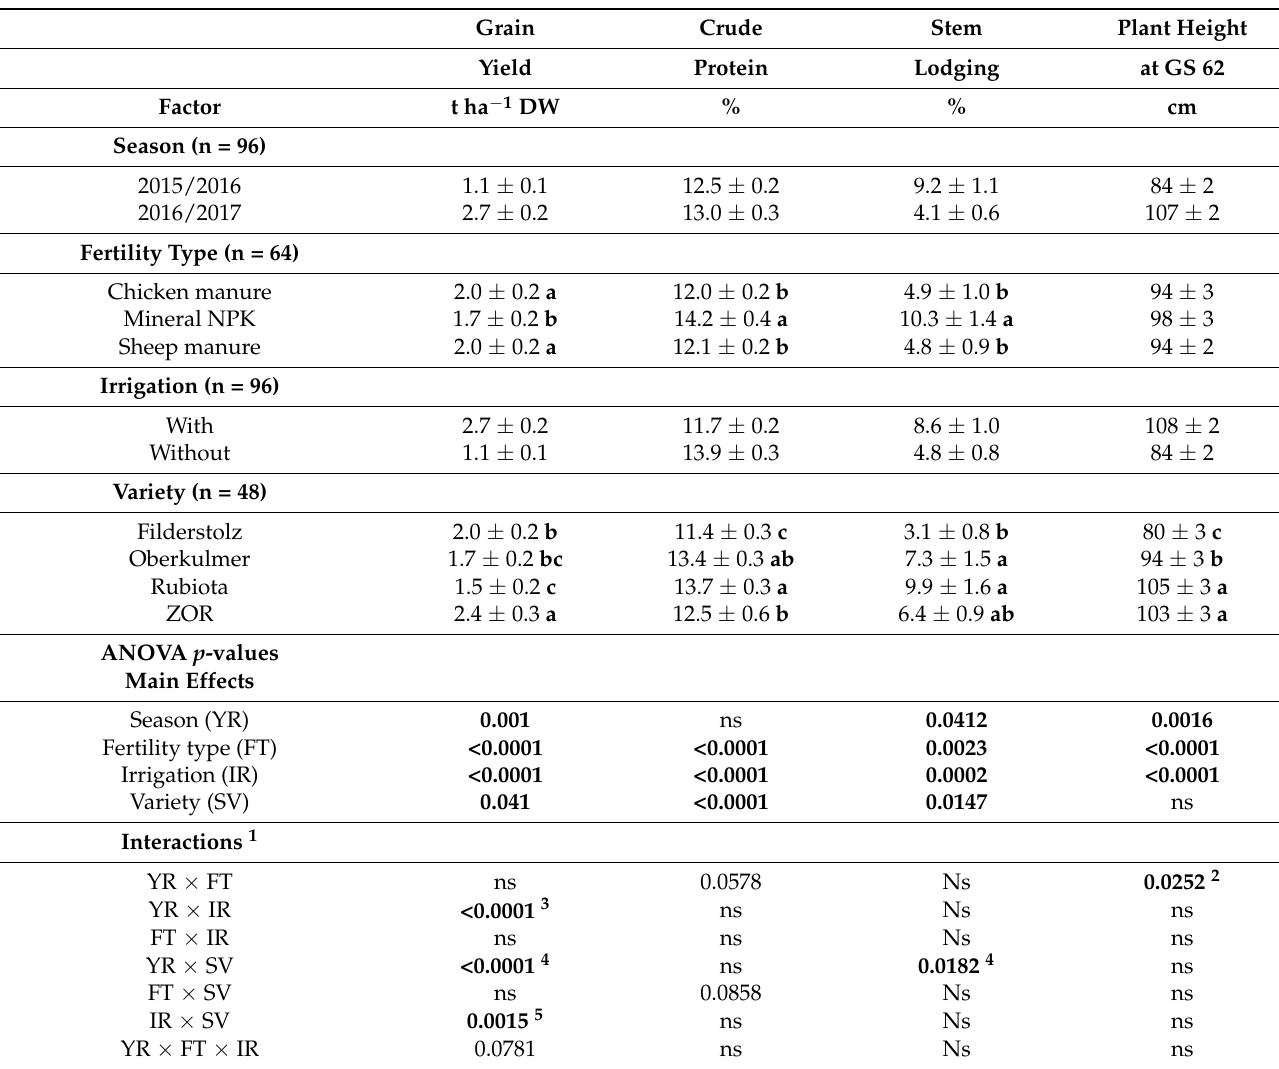
Table 4. Effects of growing season (2015/2016 and 2016/2017), supplementary irrigation (with or without), fertilizer type (chicken manure, mineral NPK, sheep manure) and variety (Filderstolz, Oberkulmer, Rubiota and ZOR) on spelt wheat grain yield, crude protein content, stem lodging and plant height. Grain Crude